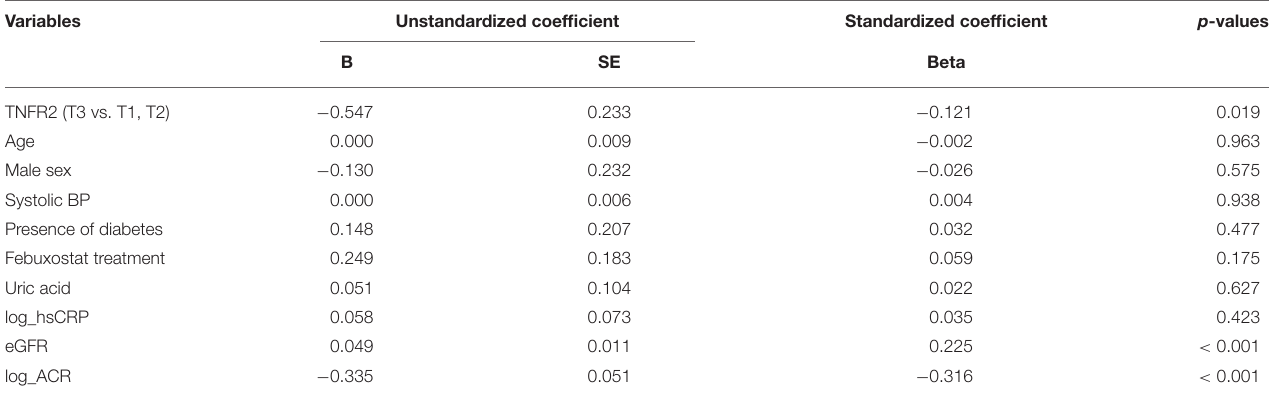
TABLE 4 | Multivariate regression analysis of the factors associated with eGFR slope in the study patients. Variables Unstandardized coefficient Standardized coefficient p